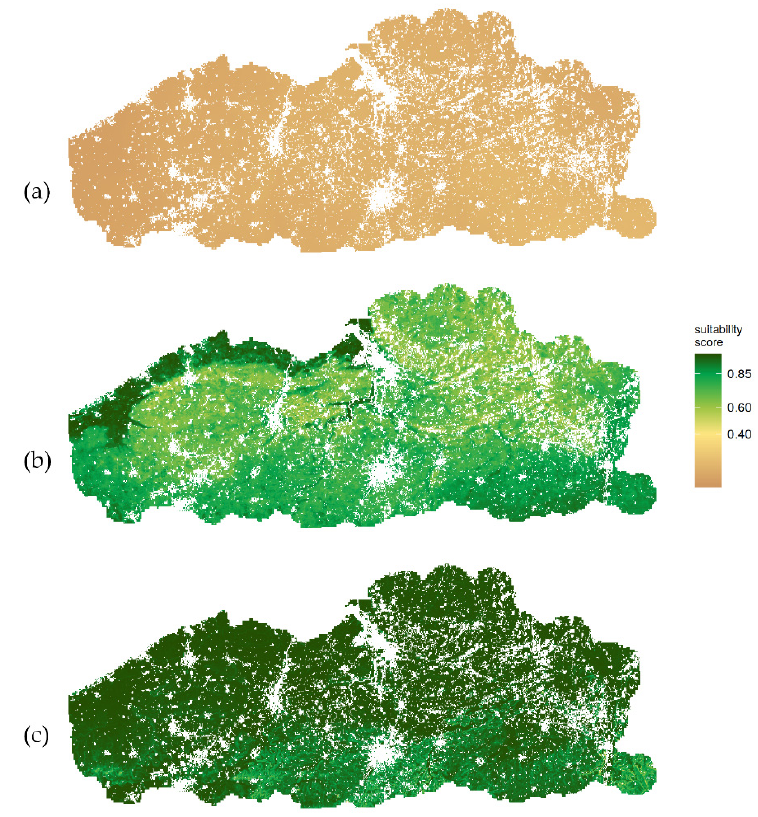
Figure 3. Suitability score maps for maize in Flanders: ( a ) climatic factors; ( b ) soil factors; ( c ) topographic factors .